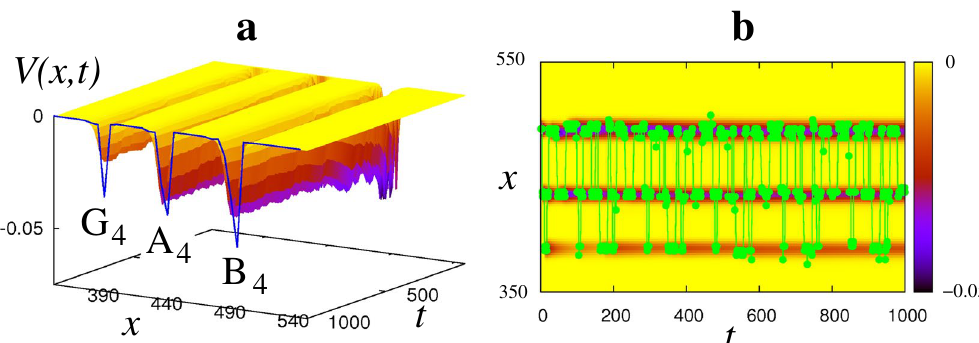
Figure 4. Musical notes recognition. ( a ) Evolution of the landscape V ( x , t ) in response to a musical signal performed by an amateur musician. Local minima that develop eventually are very close to the frequencies of the musical notes G 4 , A 4 and B 4 that enter the song. ( b ) Filled circles show the actual values of the input, and the shade of the background shows the depth of the